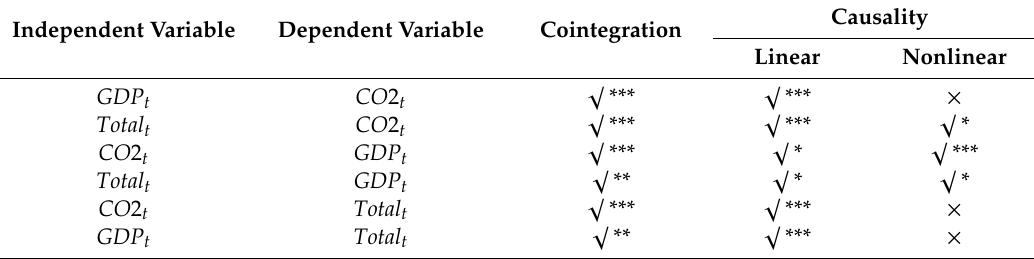
Causality Linear Nonlinear √